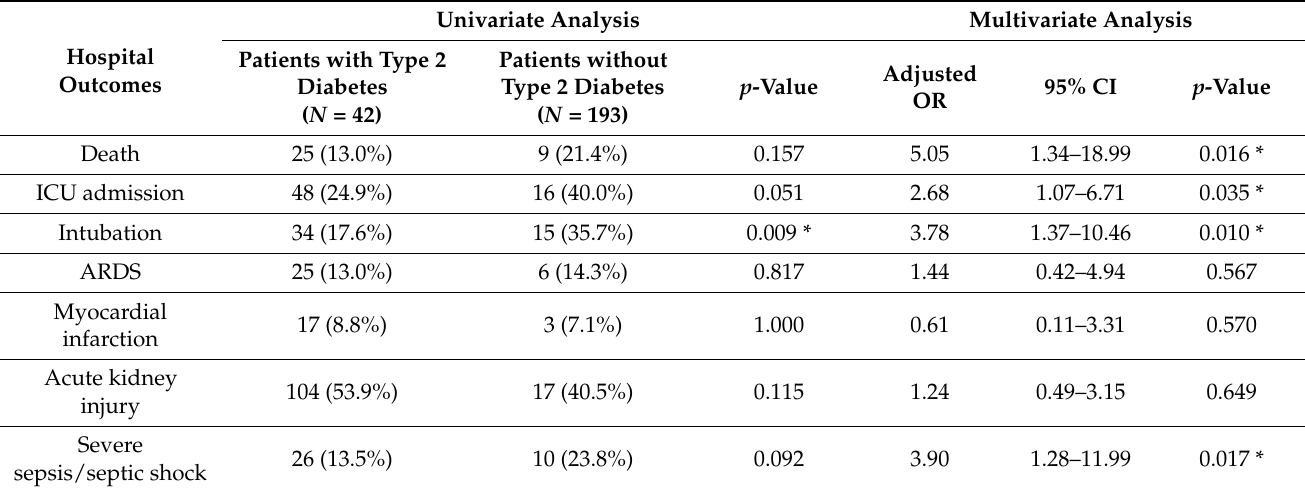
Table 4. Comparison of hospital outcomes between patients with and without type 2 diabetes among patients with admission blood glucose >200